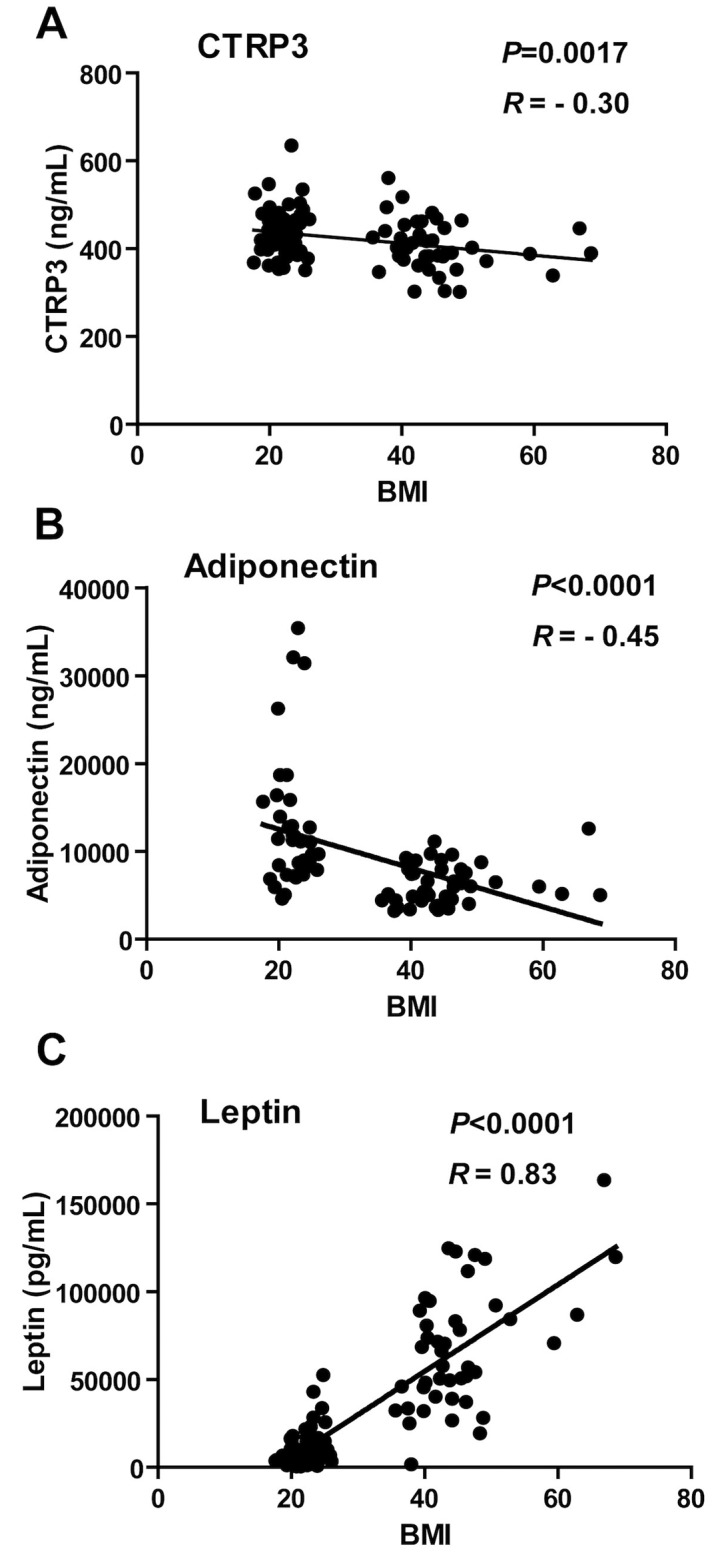
(A) and (B) CTRP3 is inversely related to BMI, analogous to adiponectin. (A) and (C) CTRP3 and Leptin have opposite relationships with BMI.Pearson’s r = correlation coefficient (p<0.05).